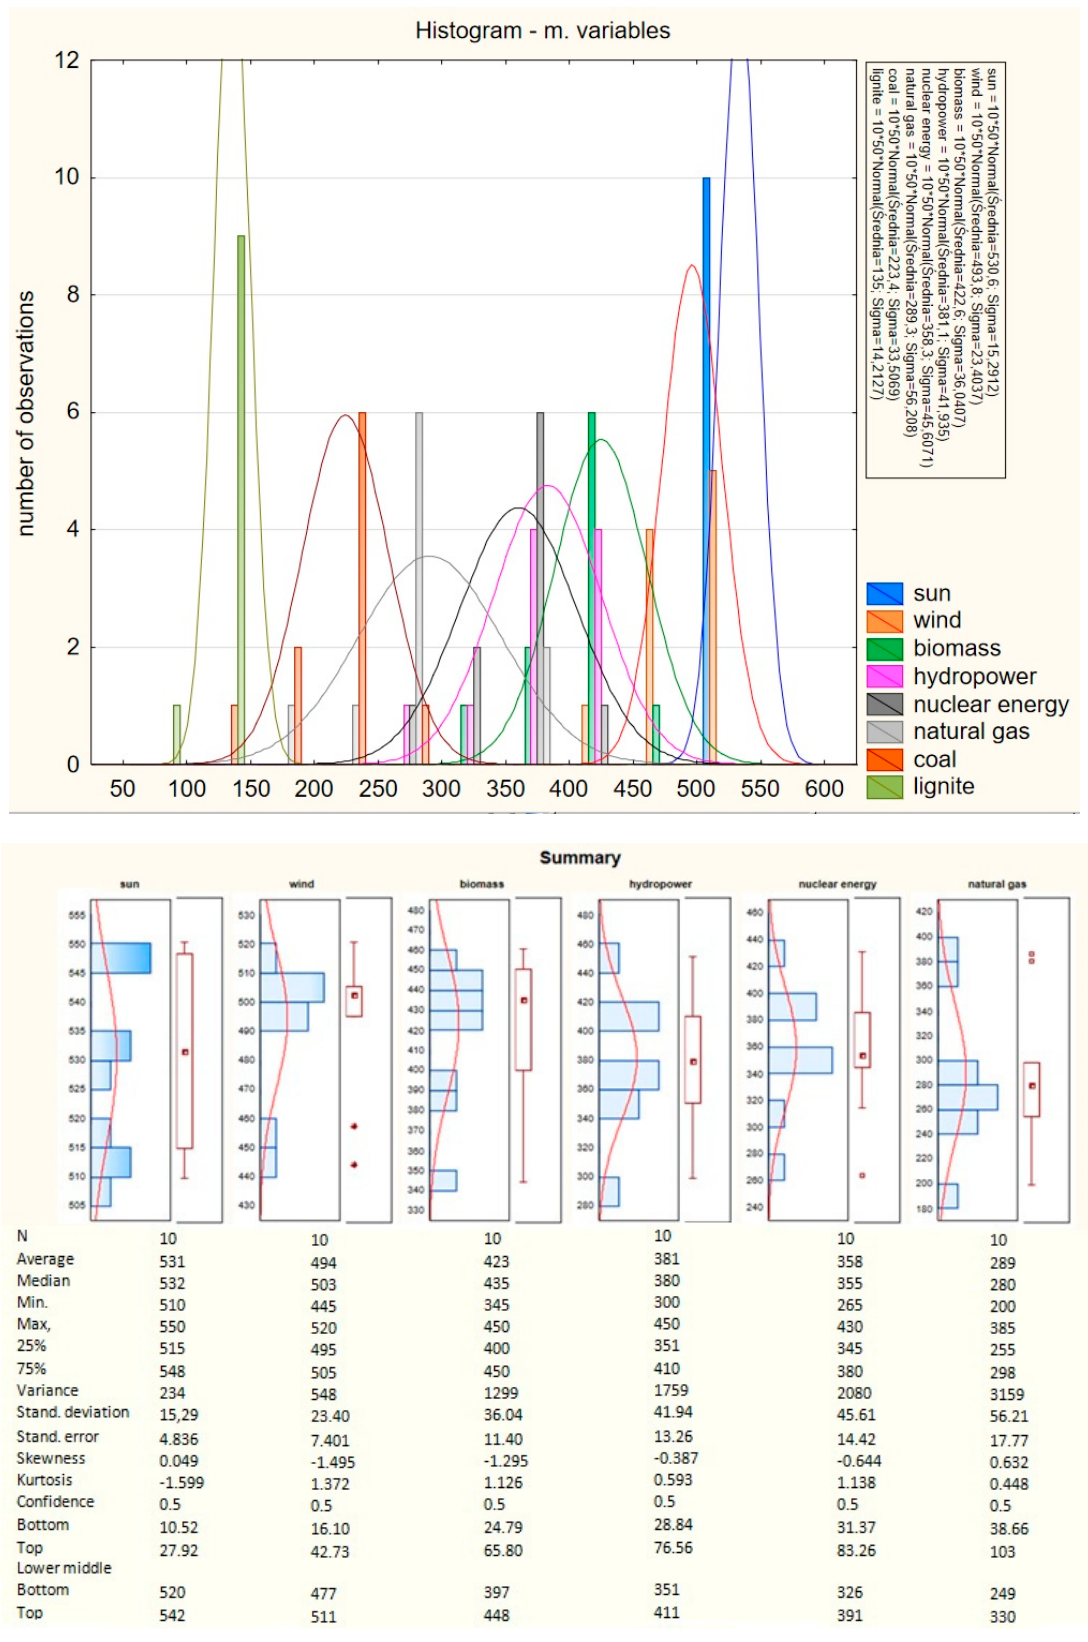
Figure 31. Estimation of the average planned electricity production in Germany (based on the actual annual average using the program STATISTICA).